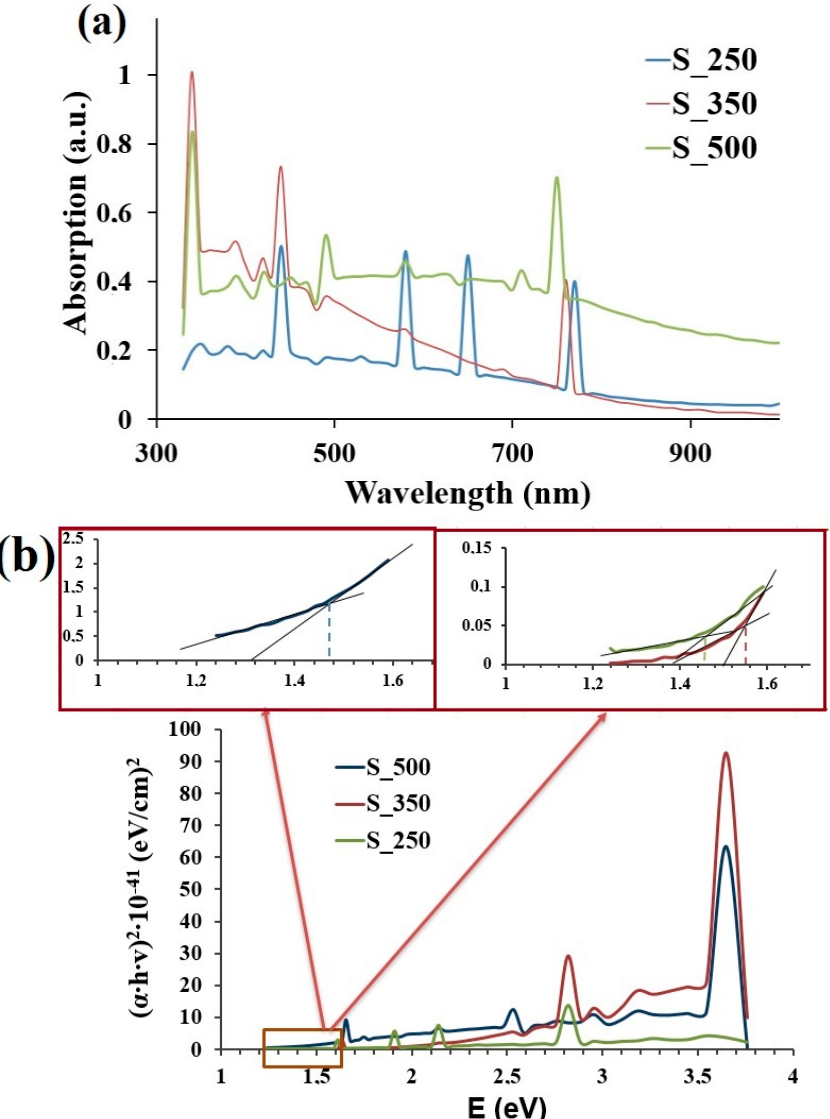
Figure 3. Optical properties of the films: ( a ) UV–VIS absorption spectra and ( b ) Tauc plot of direct transitions.